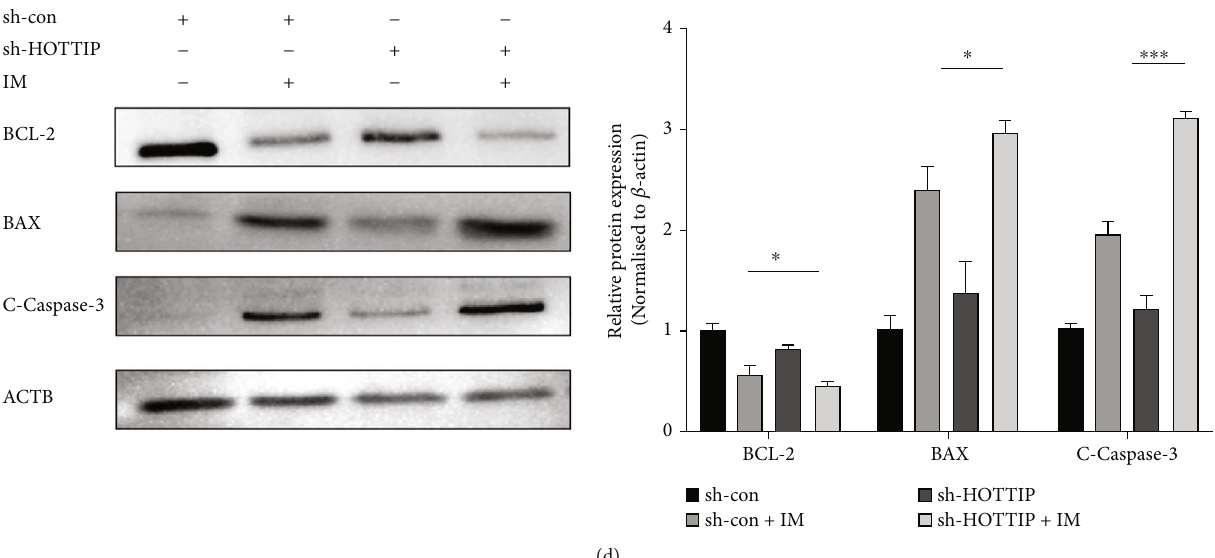
Figure 4: Knocking down HOTTIP increases the sensitivity of IR-K562 cells to IM. Note: (a) IR-K562 was transfected with speci fi c sh-RNA of HOTTIP or negative sh-RNA (sh-con). RT-qPCR was used to detect HOTTIP level. CCK-8 analysis was used to detect cell proliferation. (b) IR-K562 cells were transfected with speci fi c sh-HOTTIP or negative sh-con and treated with di ff erent Imatinib concentrations for 48 h. CCK-8 analysis was used to detect cell inhibition. ∗ p < 0 : 05 vs. sh-con. (c) IR-K562 cells were transfected with speci fi c sh-HOTTIP or negative sh-con and treated with di ff erent concentrations of Imatinib for 48h. Cell apoptosis was detected by fl ow cytometry using Annexin V/APC/PI. The right panel shows the apoptosis rate from three independent experiments. ∗∗ p < 0 : 01 vs.sh-on. (d) Western blotting for protein levels in IR-K562 cells transfected with sh-HOTTIP or negative sh-con and treated with IM (3 μ M) or DMSO for